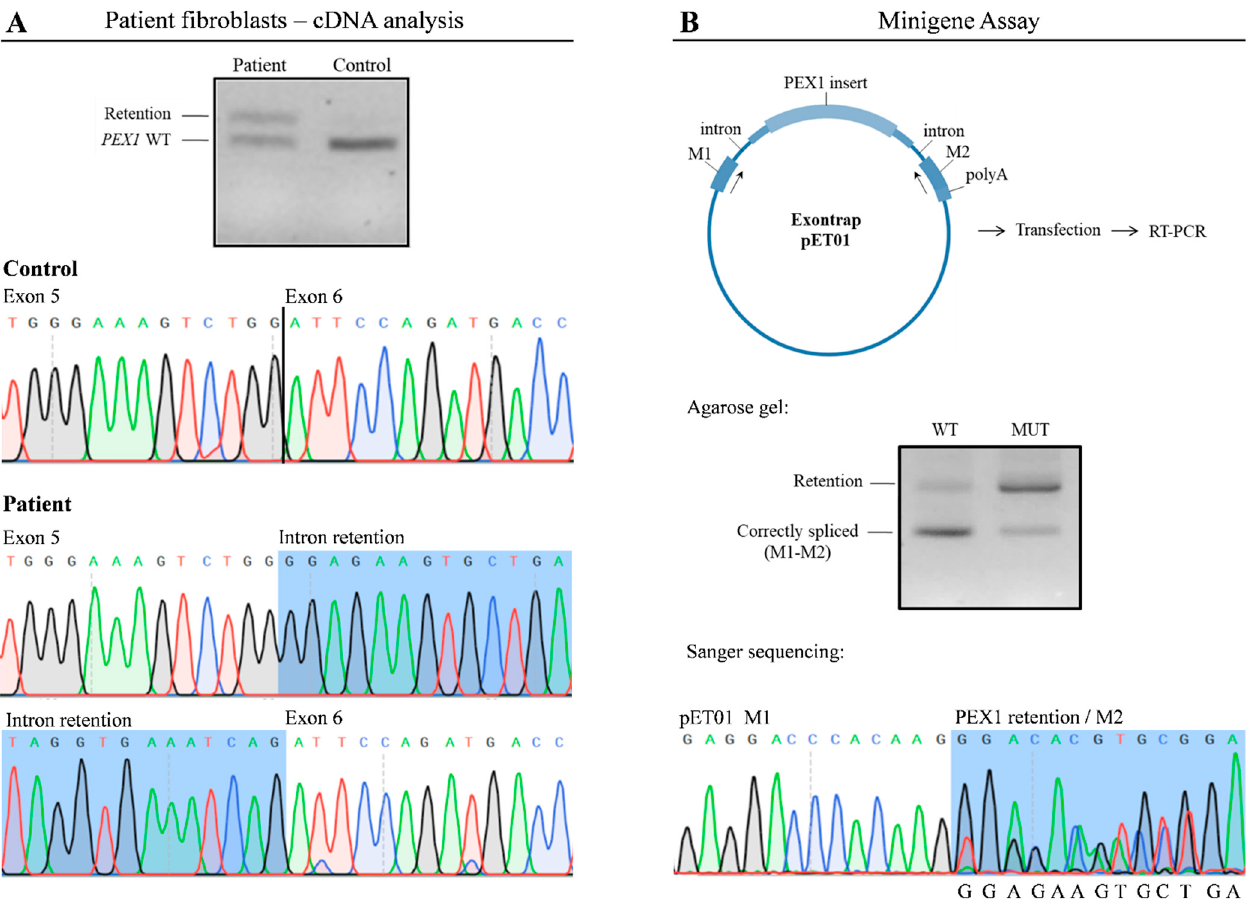
Figure 3. The c.1240-1551A>G variant leads to altered PEX1 mRNA processing. ( A ) RT-PCR fol- lowedby agarose gel analysis and Sanger sequencing showed the exonization of a PEX1 intronic sequence in patient’s fibroblasts. ( B ) A minigene assay was performed to determine functional impact of the c.1240-1551A>G variant. Wild type and mutant plasmids were transfected into HAP1 cells followed by RT-PCR. A predominant 200 bp product corresponding to correctly-spliced pET01 mRNA was detected upon transfection with wild type plasmids. In contrast, altered splicing was detected in cells transfected with the vector containing the c.1240-1551A>G variant, showing a significant overrepresentation of a 320 bp fragment. WT, wild type; MUT, mutant.